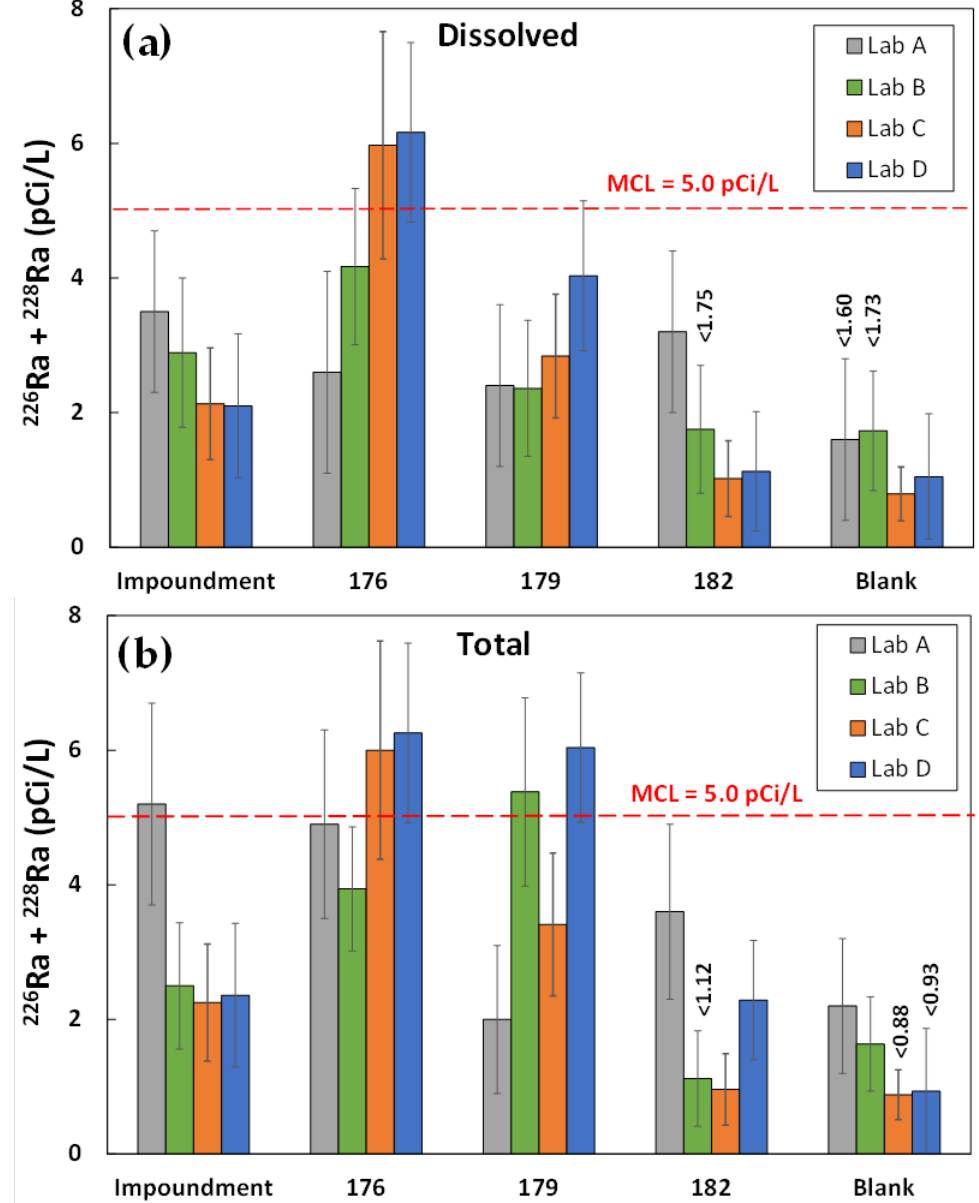
Figure 7. Interlaboratory comparison of ( a ) Dissolved 226 Ra + 228 Ra; ( b ) Total 226 Ra + 228 Ra. Values in black signify the MDC when the reported values were less than the MDC.